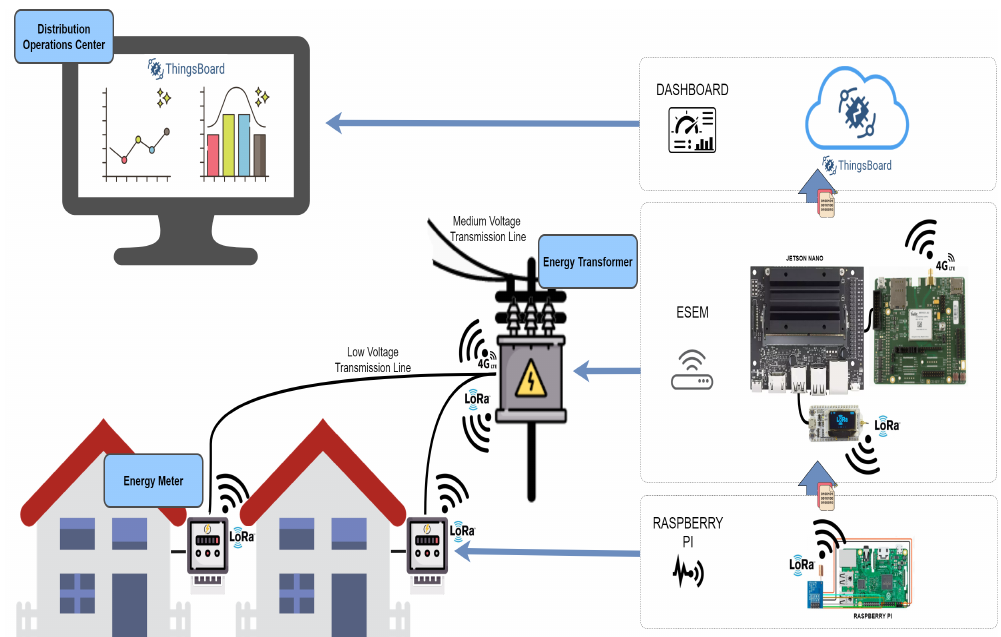
Figure 2. Implementing the chosen Decentralised